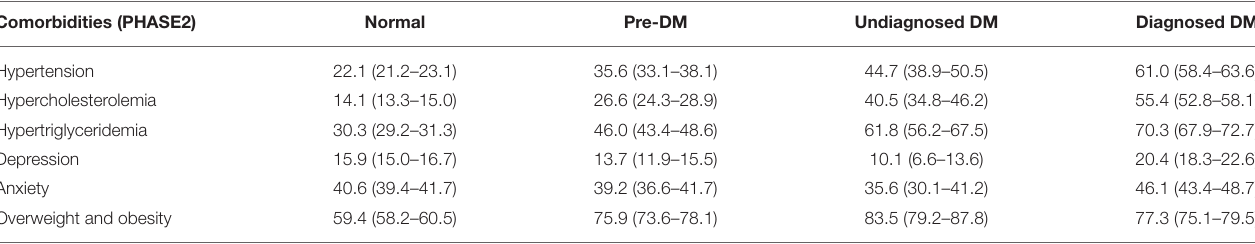
TABLE 3 | The prevalence % (CI) of different comorbidities in normal, pre-diabetes, and undiagnosed and diagnosed diabetes, community-based cohort study (KERCADR − 2nd Phase- N = 9,959), Kerman, Iran, 2014–2018. Comorbidities (PHASE2)